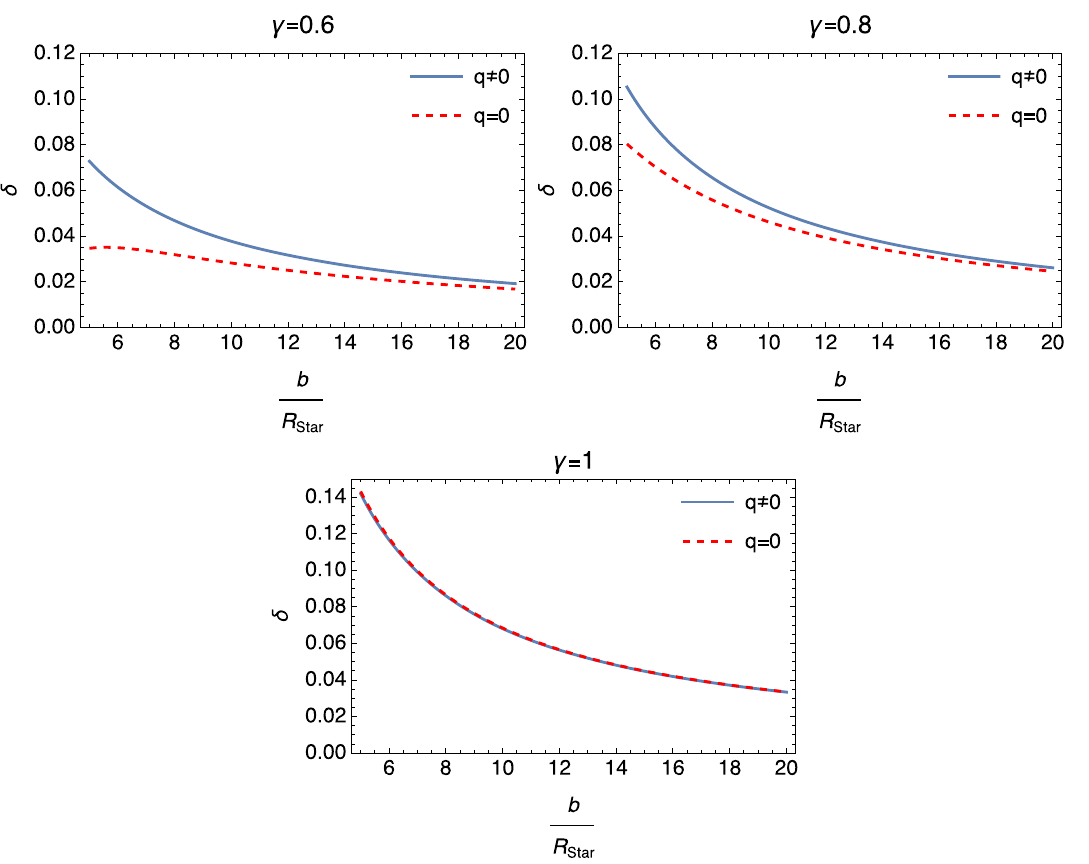
Fig. 4 The plot of deflection angle δ versus x = b / R Star for 4 U 1538 − 52. Different curves correspond from left to right to the cases γ = 0 . 6, γ = 0 . 8 and γ = 1. Note that in all plots we have chosen for the charge parameters q = p = 1 / uncharged